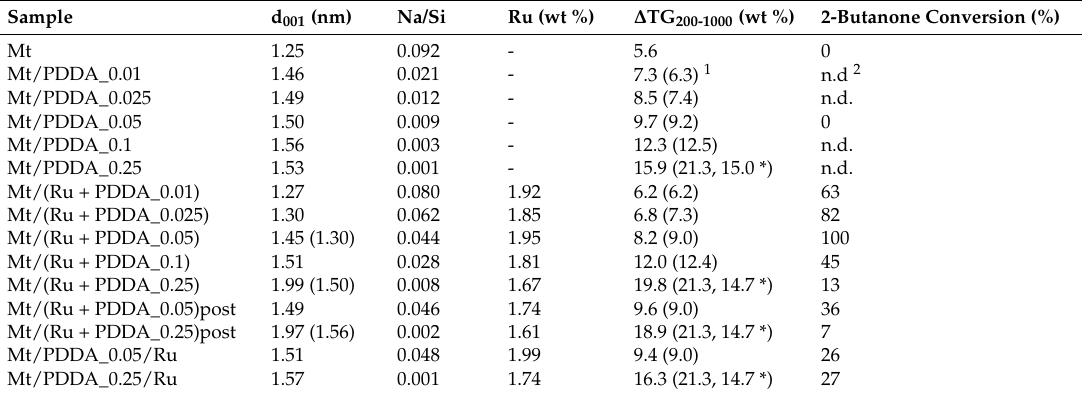
Table 1. Basal spacing, Na/Si atomic ratio, Ru content, mass loss in the 200–1000 ◦ C range, and 2-butanone conversion of studied